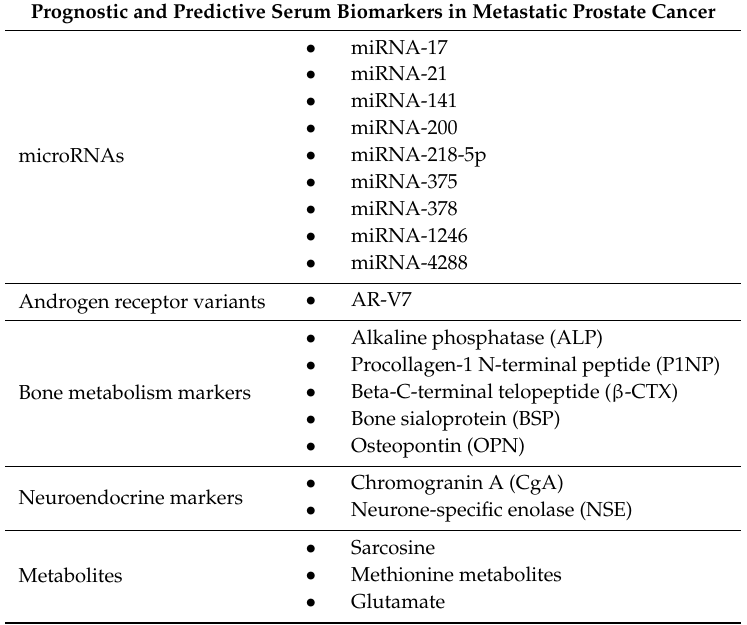
Table 1. Potential prognostic and predictive serum biomarkers in metastatic prostate